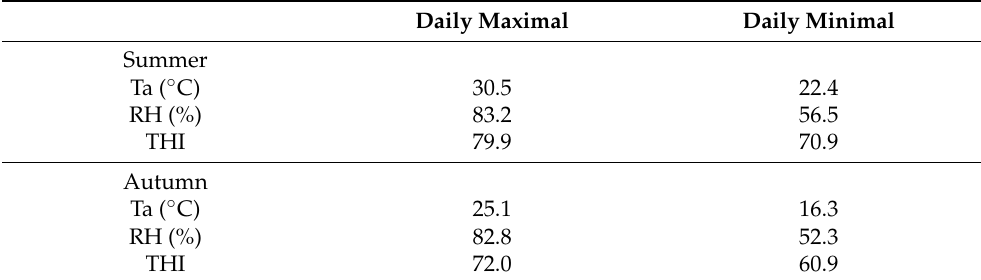
Table 1. Mean climatic conditions during the summer (July–September) and autumn (October– November) for the farms located in the coastal plain in Israel. Daily Maximal Daily